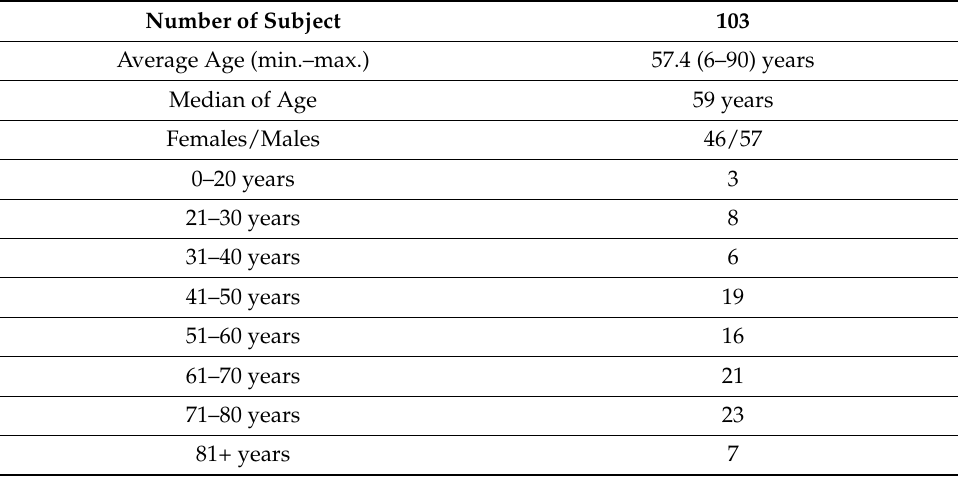
Table 1. Characteristics of studied patient